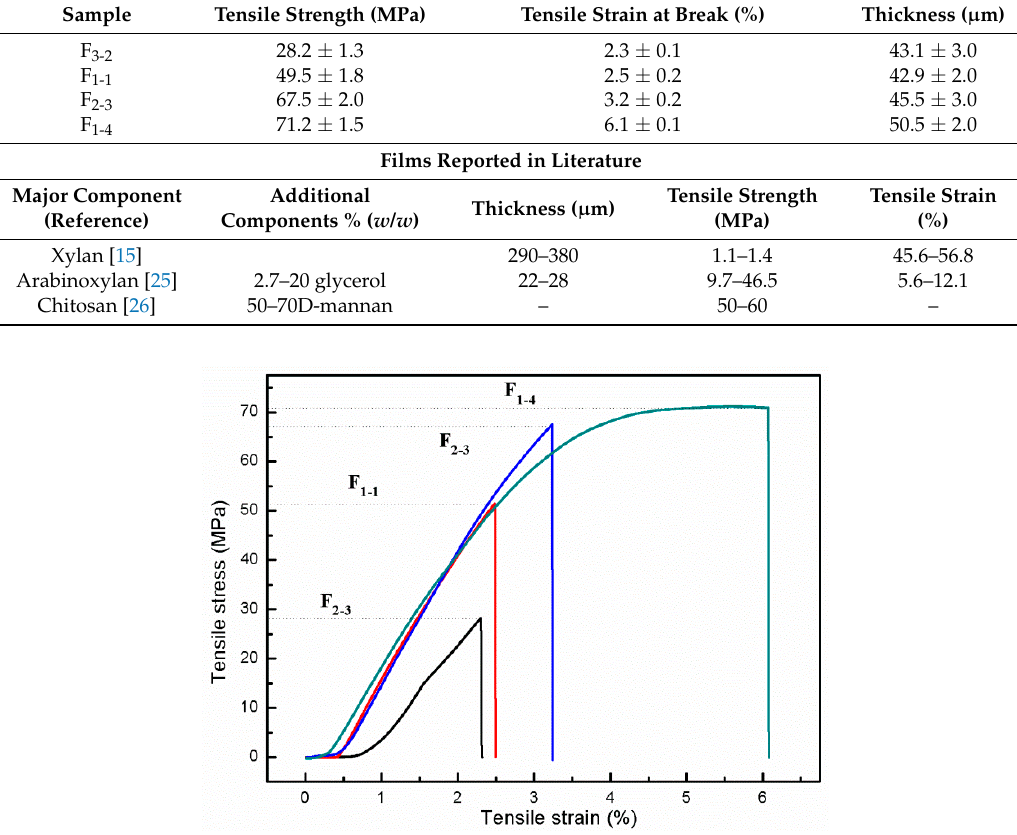
Figure 6. Tensile-strain curves of the composite films. Table 2. Tensile testing results of the composite films.